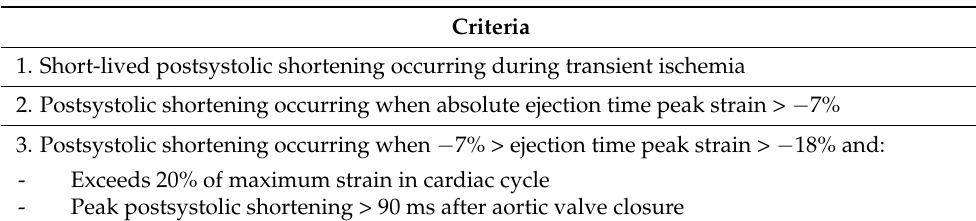
Table 1. Criteria by Voigt et al. [8] to identify pathologic postsystolic shortening by strain derived from tissue Doppler